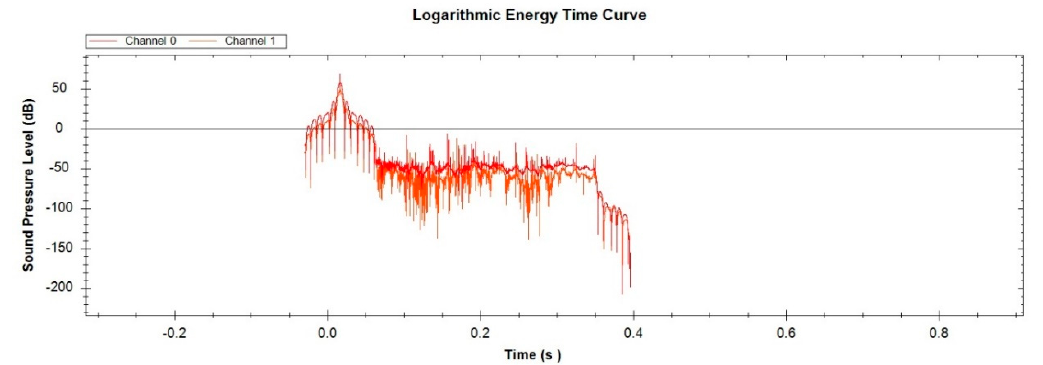
Figure 8. Logarithmic energy time curve for the hall without acoustic treatment, with channel 0 for hall in unoccupied mode and channel 1 for occupied mode.